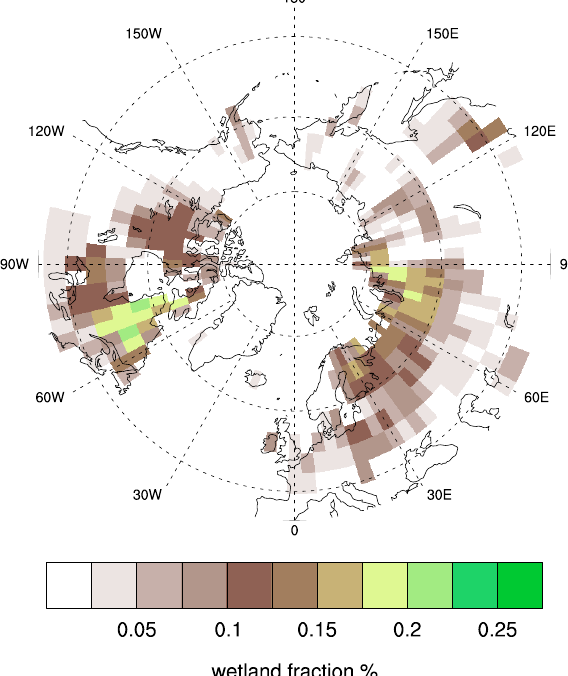
Fig. 3. Wetland fraction displayed in the model resolution used in Fig. 3. the transient simulations (as published by Kleinen et al.,